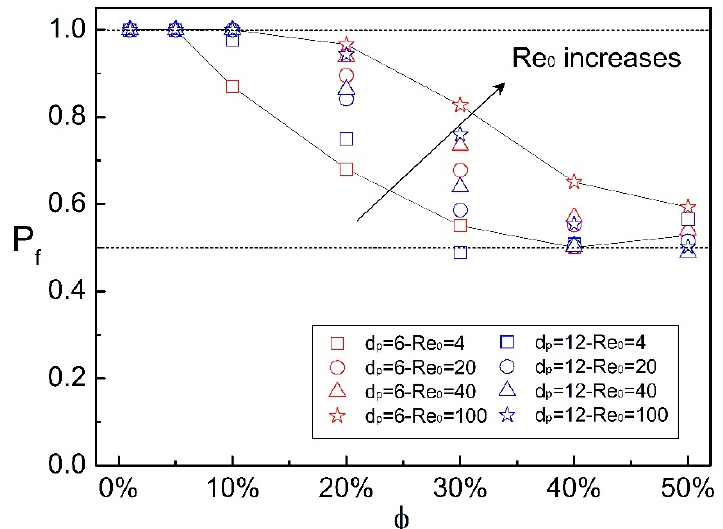
Figure 16. The degree of inertial migration P f as a function of particle concentration for different particle sizes d p and channel Reynolds numbers Re 0 . The data was originally reported in [37].